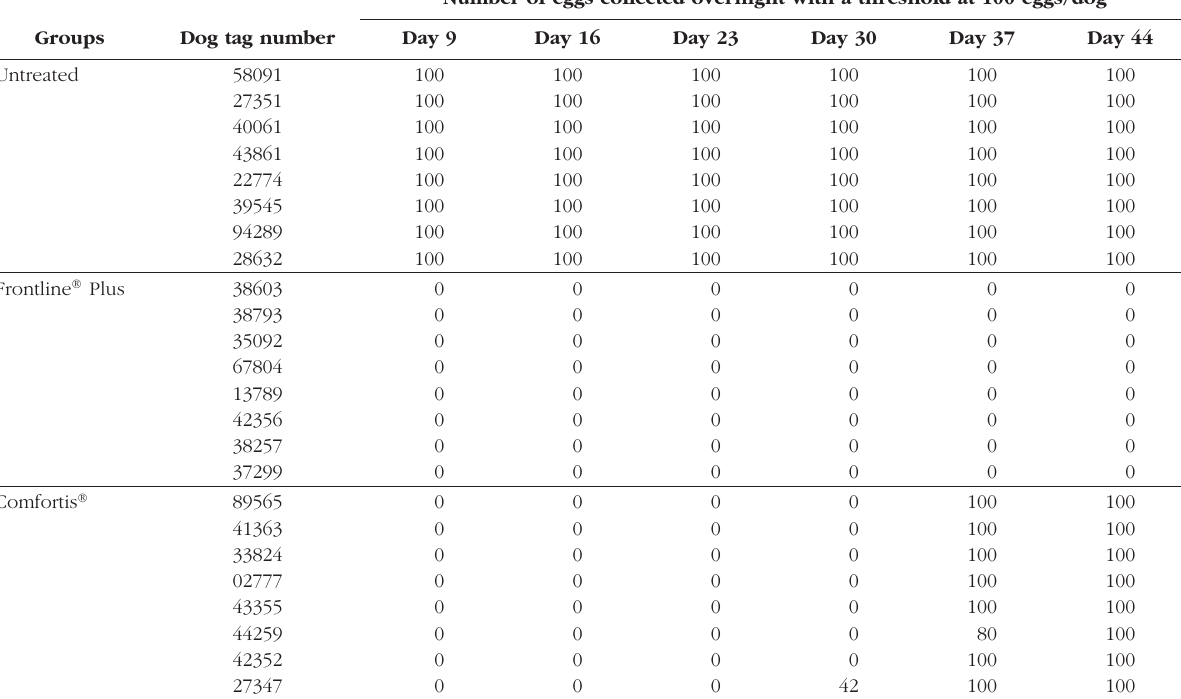
Fig 3. – Distribution of the number of live fleas per each dog at each counting point. One line represents the data observed in the same